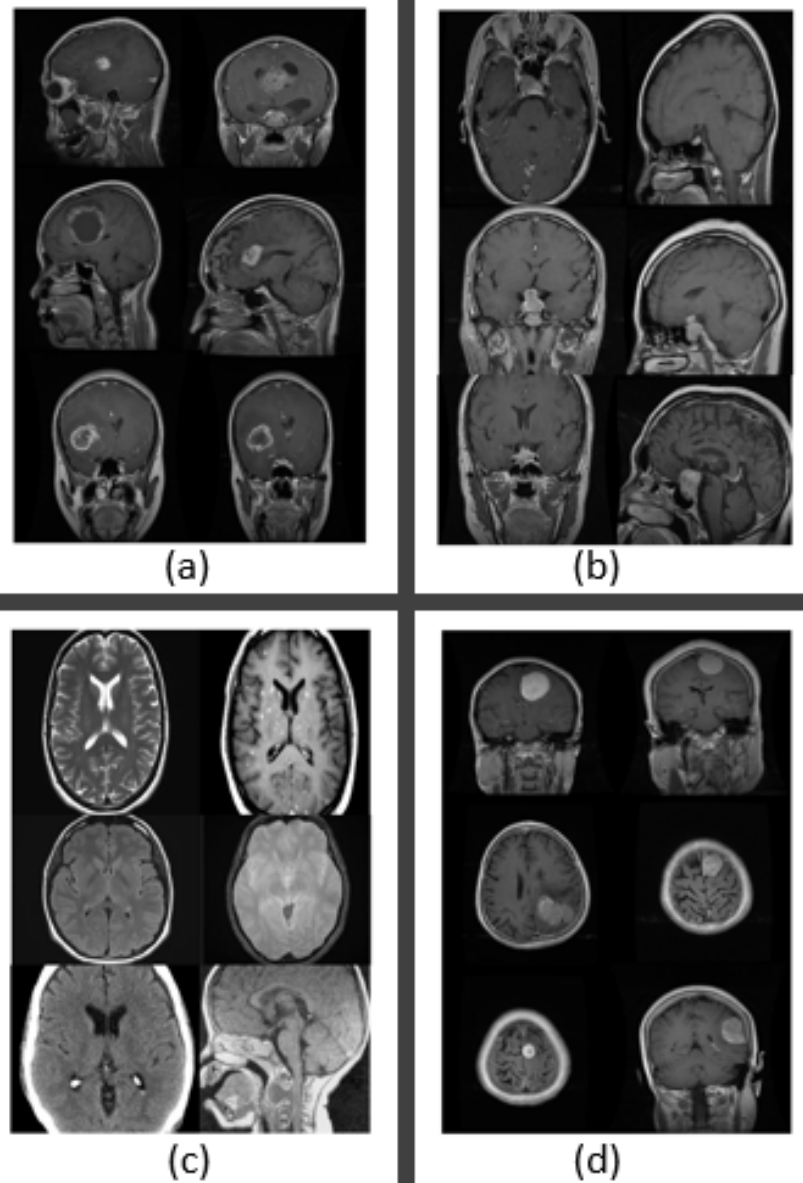
Figure 4. MR images of brain tumors. ( a ) Glioma tumor. ( b ) Pituitary tumor. ( c ) No tumor. ( d ) Meningioma